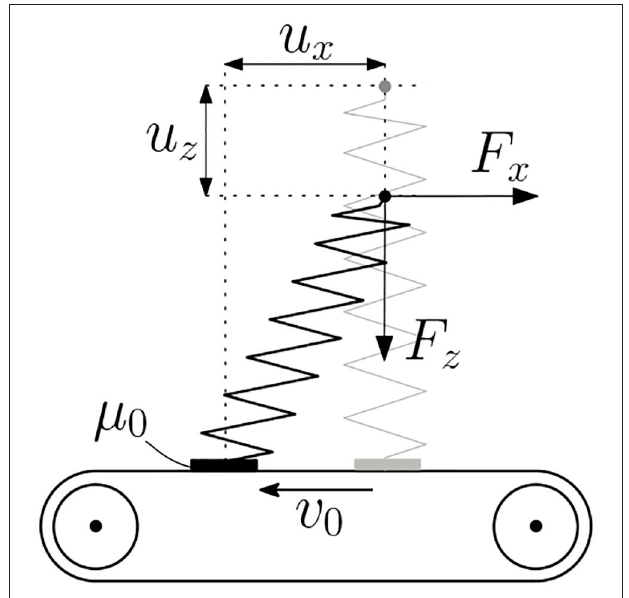
FIGURE 2 | A single massless spring, which serves as a minimal model of a sliding frictional contact. The sliding velocity is constant, while the vertical coordinate oscillates. Amontons friction with the constant coefficient of friction µ 0 is assumed in the contact